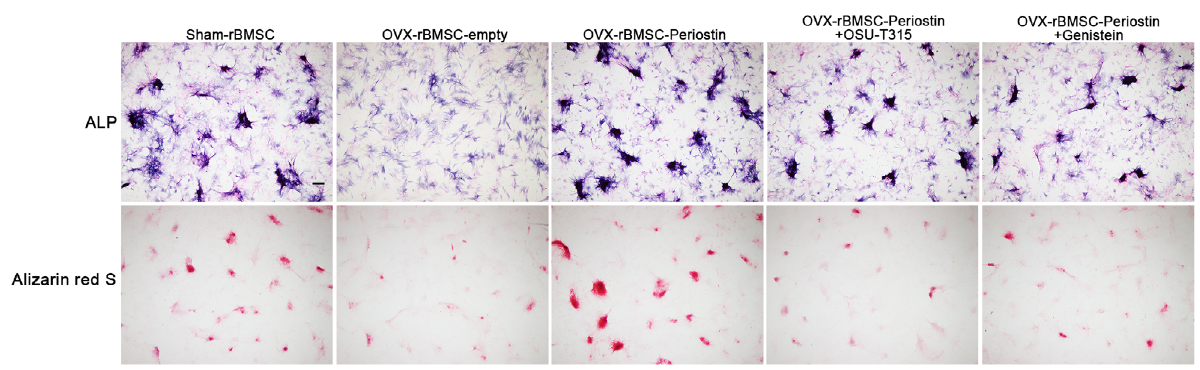
Figure 8 ‒ Periostin promotes the osteogenesis ability of OVX-BMSCs in part by action on the ILK/Akt/GSK3 axis. (A) Representative images of ALP staining of the indicated groups on day 7 after osteogenesis induction. The images are from 1 of 3 independent experiments, magnification × 40. (B) Representative images of ARS staining of the indicated groups on day 7 after osteogenesis induction, magnification × 40, scale bar = 200